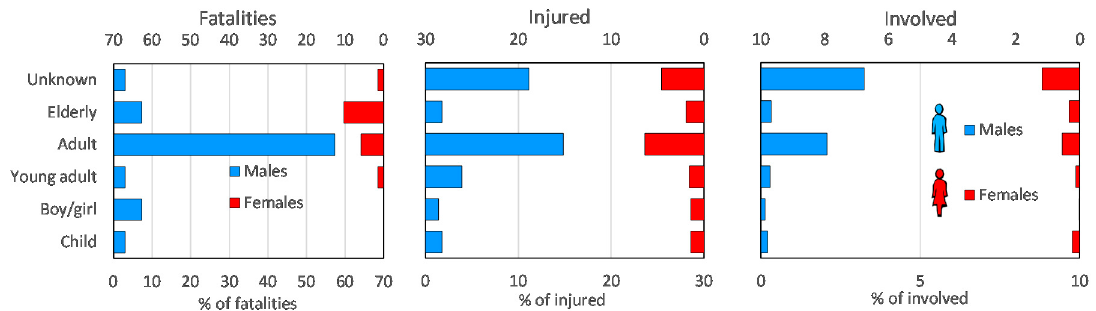
Figure 3. Age and gender of fatalities, injured and involved people (for the three diagrams, Y axis has the same legend reported on the first diagram). the same legend reported on the first